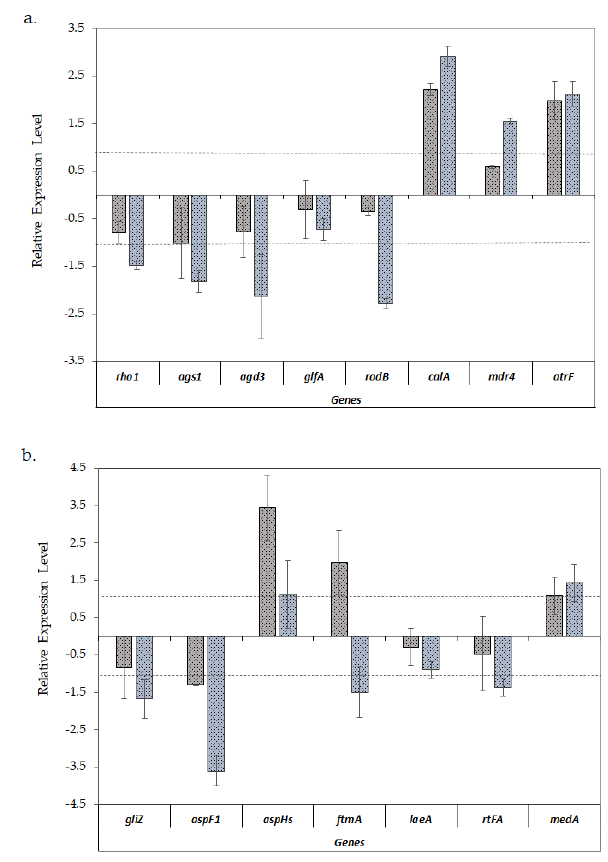
Figure 3. Relative expression ± S.D. of the virulence-related genes of A. fumigatus LMB-35Aa between the biofilms developed on polyester (grey bars) and polystyrene (blue bars) vs. planktonic cultures: ( a ) analysis of genes of the cell wall structure, hydrophobin, invasin and efflux transporters; and ( b ) the genes involved in mycotoxin biosynthesis, adhesion, and secondary metabolism. Gene expression levels were normalized using β -tub and tef1 as reference genes. The relative expression level is represented as a log 2 fold change; dotted lines indicates log 2 fold change thresholds of − 1 and 1.